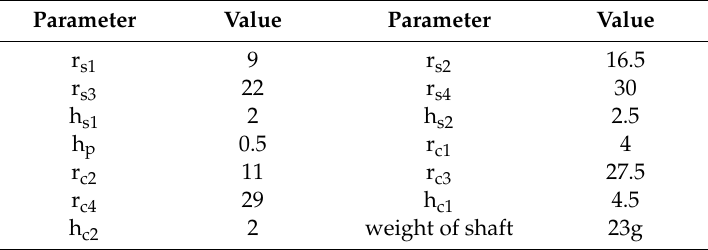
Table 1. Key parameters of a travelling-wave ultrasonic motor (unit: mm).